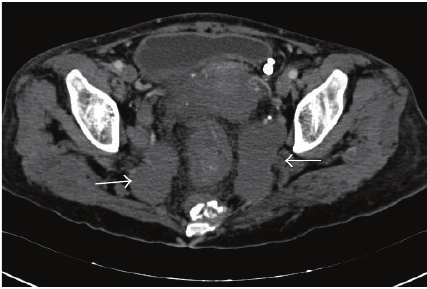
Figure 2: Axial contrast enhanced (arterial phase) CT of the pelvis demonstrating abnormal dilated lymphatic channels (arrows).